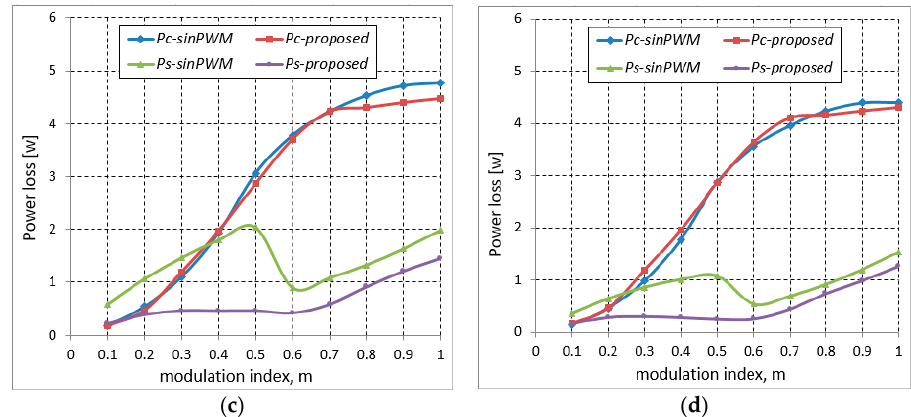
Figure 5. Power loss on a phase under sinPWM method and proposed algorithm at carrier frequency of ( a ) 20 kHz, ( b ) 15 kHz, ( c ) 10 kHz, and ( d ) 5 kHz.